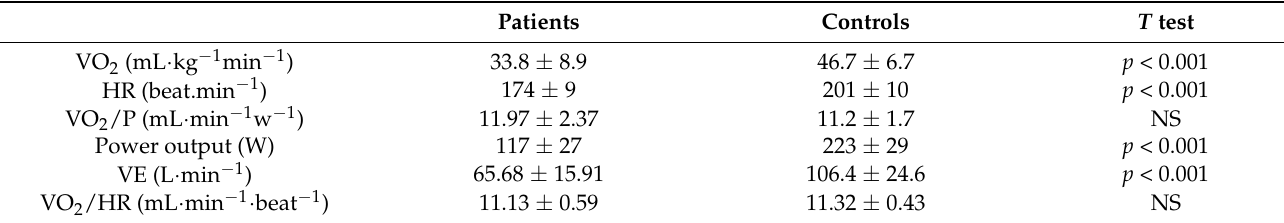
Table 2. Maximal cardiorespiratory